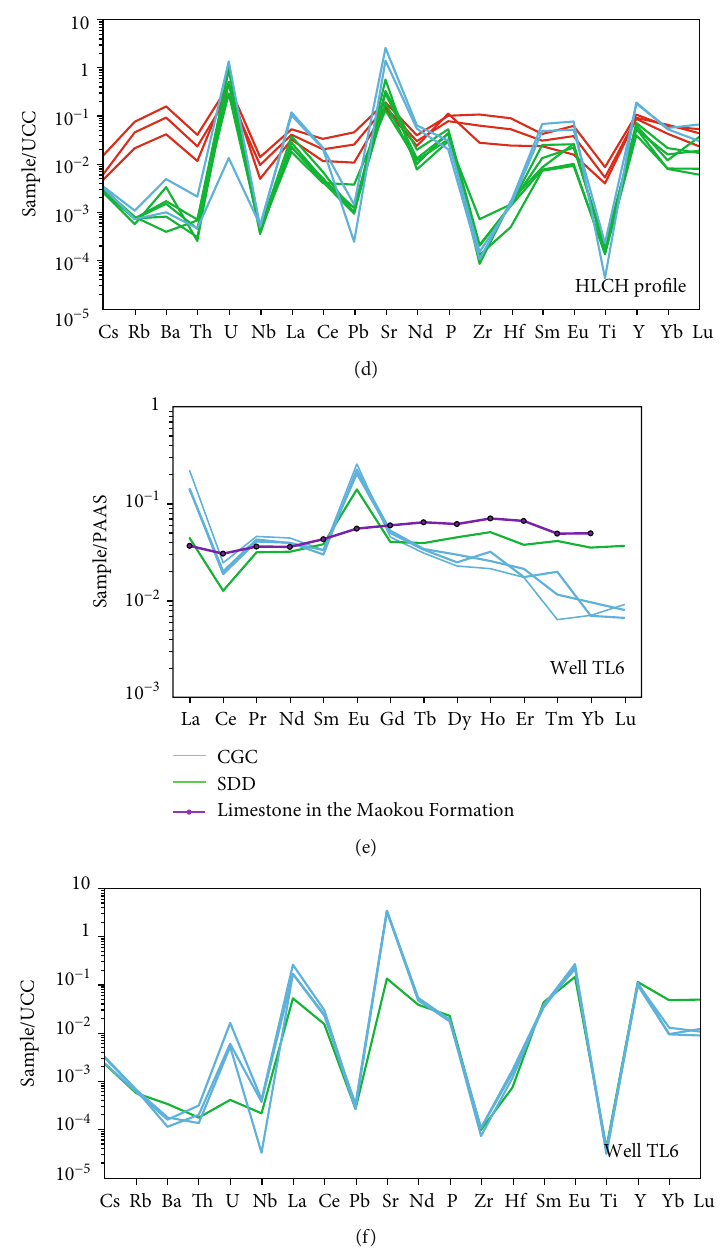
Figure 7: Post-Archean Australian Shale- (PAAS-) normalized rare-earth element (REE) patterns and Upper Continental Crust- (UCC-) normalized trace element spidergrams. The limestone in the Maokou Formation was from Li et al. [41]. PAAS data were from Mclennan et al. [62]. UCC data were from Rudnick and Gao